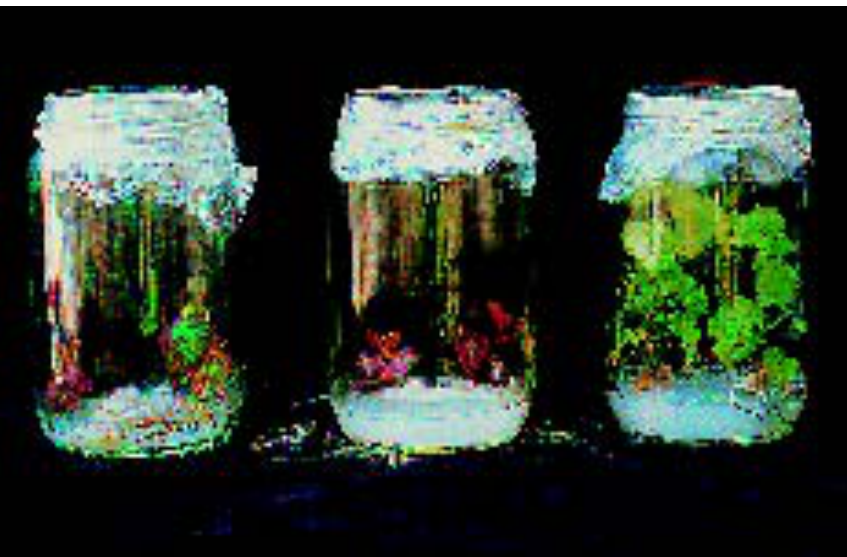
Fig. 3. Plantlets of cv. C. Sauvignon inoculated with Phellinus sp. showing reduced growth and reddish leaves (two flasks at the left). Control: flask at the